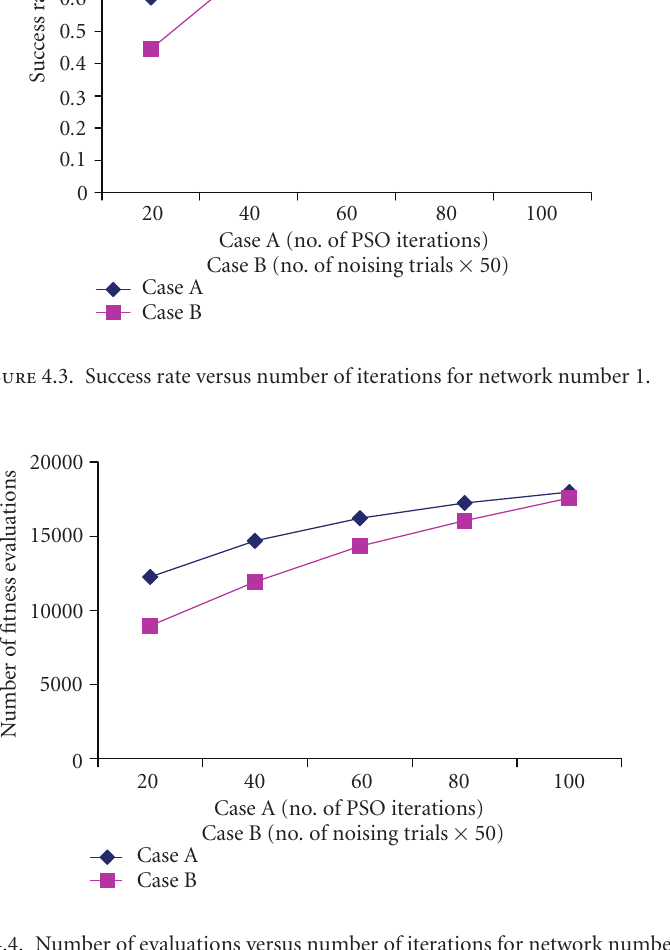
Figure 4.4 . Number of evaluations versus number of iterations for network number